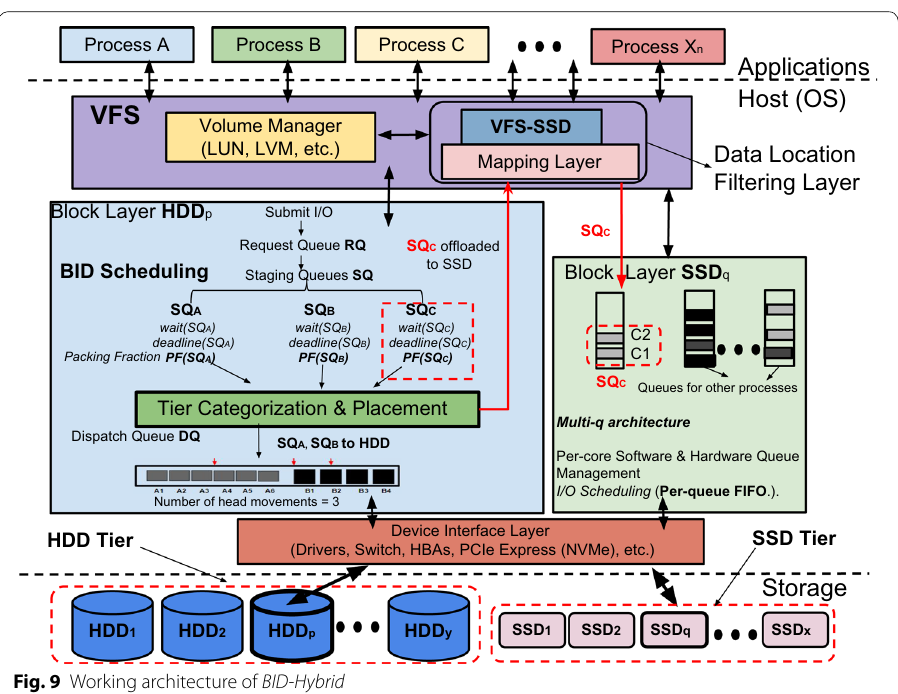
Fig. 9 Working architecture of